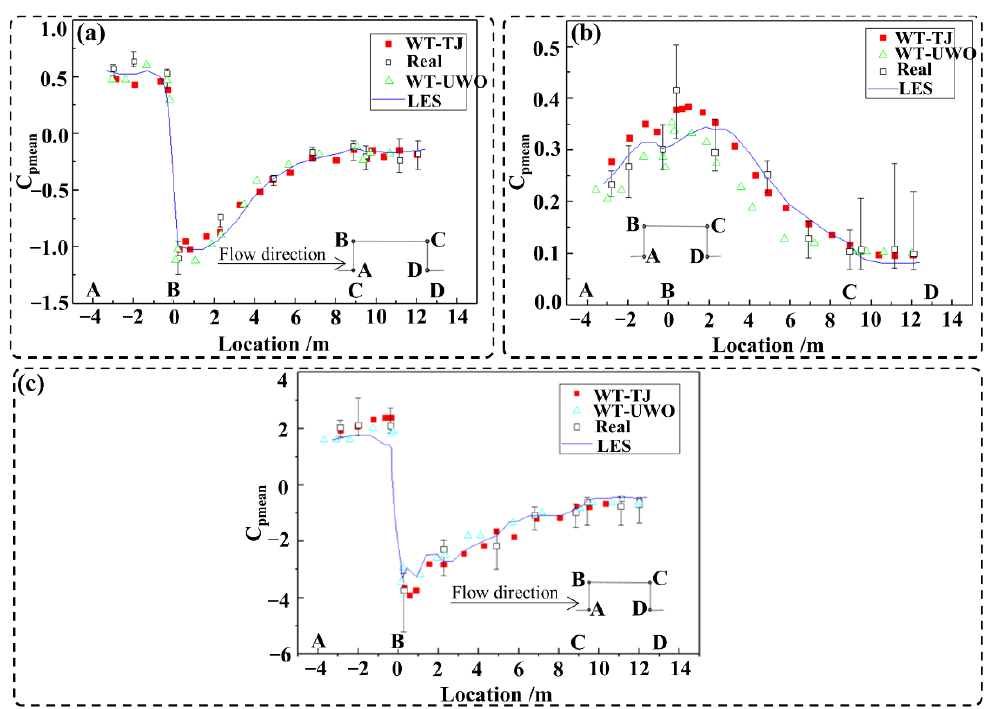
Figure 7. Comparison of pressure coefficients: ( a ) average pressure coefficient; ( b ) pulsation wind pressure coefficient; ( c ) peak wind pressure coefficient. A-B, B-C, and C-D are the windward wall, roof, and backwind wall, respectively.